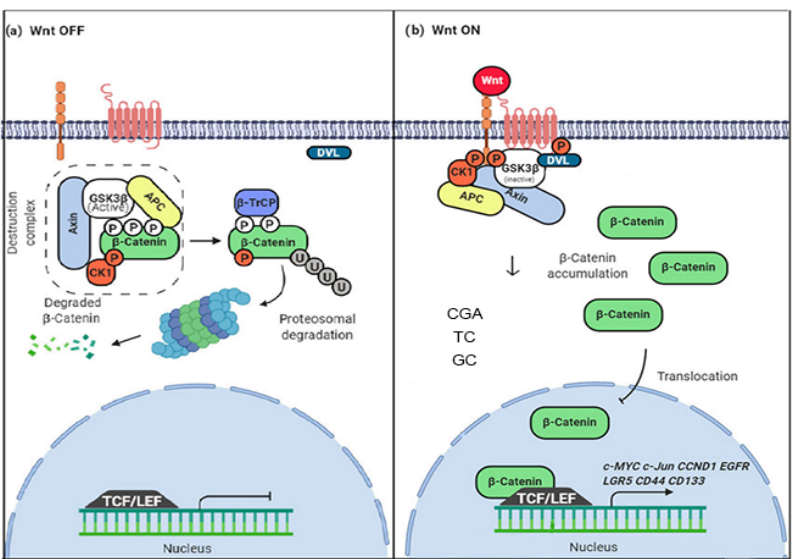
Figure 1. Mechanism of modulation of the Wnt/ β -catenin pathway by coffee polyphenols. ( a ) Normal OFF state. The β -catenin degradation complex regulates the levels of β -catenin and controls its transcriptional activator activity ( b ) The normal ON state. The β -catenin degradation complex doesn’t work, β -catenin levels increase, and translocation to the nucleus possibility its transcriptional activity. The possible mechanism of modulation associated with coffee polyphenols; CGA (Chrologenic acid), TC (Toasted coffee), and GC (Gree coffee) decrease the levels of β -catenin in the cytoplasm and nucleus, possibly through a β -catenin degradation mediation and nuclear translocation inhibition. Figure adapted from [14].